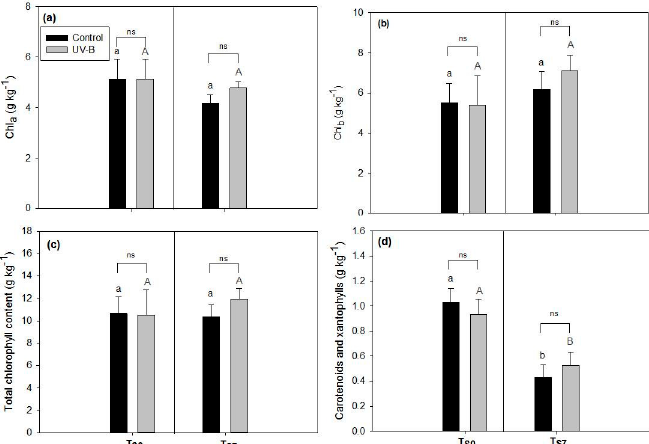
Figure 4. Photosynthetic pigment content (( a – c )—chlorophylls a , b , and total, respectively; ( d )—carotenoids, in g kg − 1 of dry weight) of leaves of O. basilicum plants cultivated under white light (control—black bars) and supplemental UV-B radiation (UV-B—gray bars) at the end of the light treatment (before storage T S0 ) or after seven days of storage (T S7 ). Mean ± SD ( n = 3). Letters show the comparison between di ff erent storage times (T S0 or T S7 ) under the same light conditions (uppercase gray letters—UV-B treatment; lowercase black letters—control). Di ff erent letters indicate significant di ff erences between the values ( p < 0.05), while asterisks show significant di ff erences between light treatments at the same time of storage; ns = not significant.